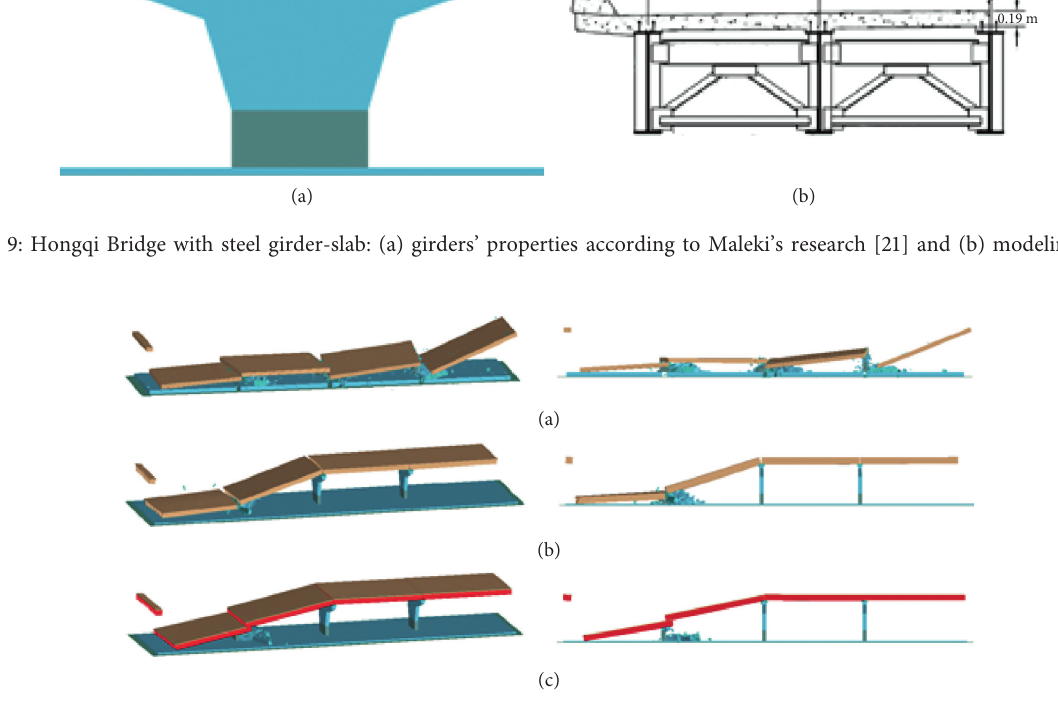
Figure 10: State of the models at the time of 12sec: (a) hollow slab deck, (b) concrete slab on concrete girder, and (c) concrete slab on steel girder.